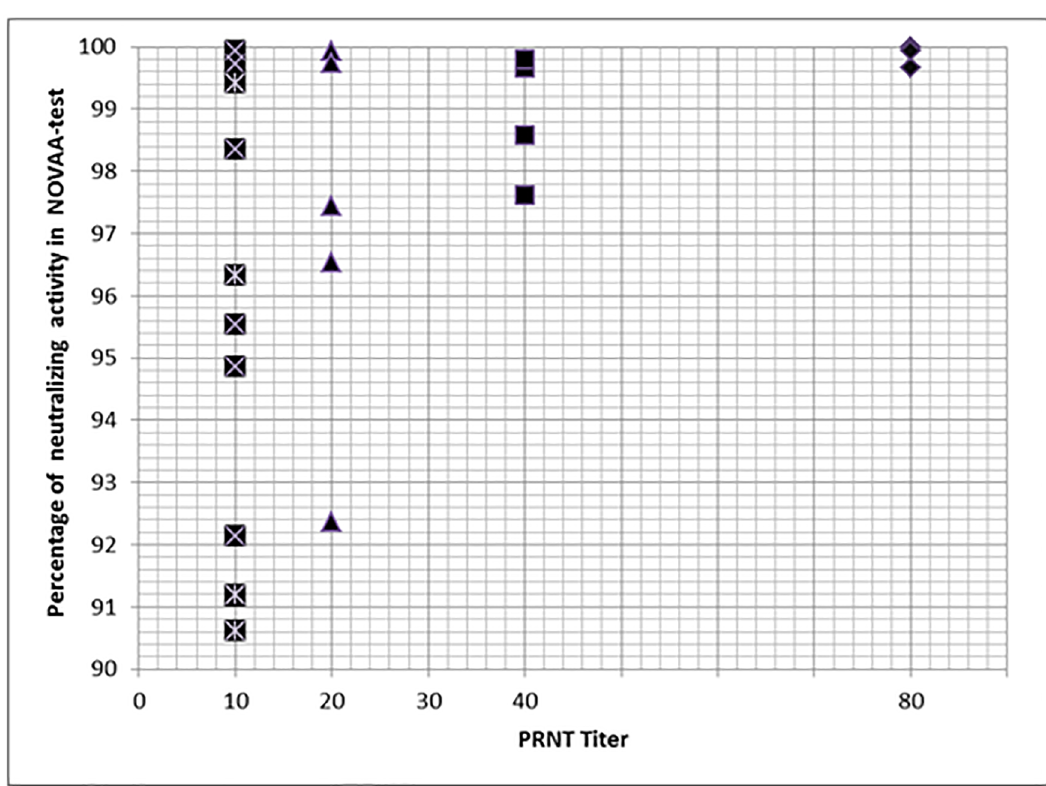
Fig 1. NOVAA-test results: Percentage of neutralization with 20 sera from patients with PRNT titres ranging from 10 to 80. Four complementary sera with a previousPRNT results of 40 were diluted 1:4 in order to surroundthe cut-off for neutralizingantibody detectionby PRNT.